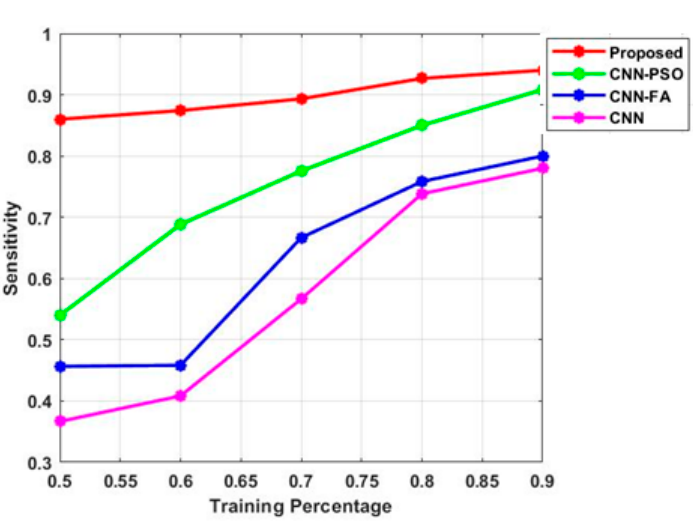
Figure 4. Precision.